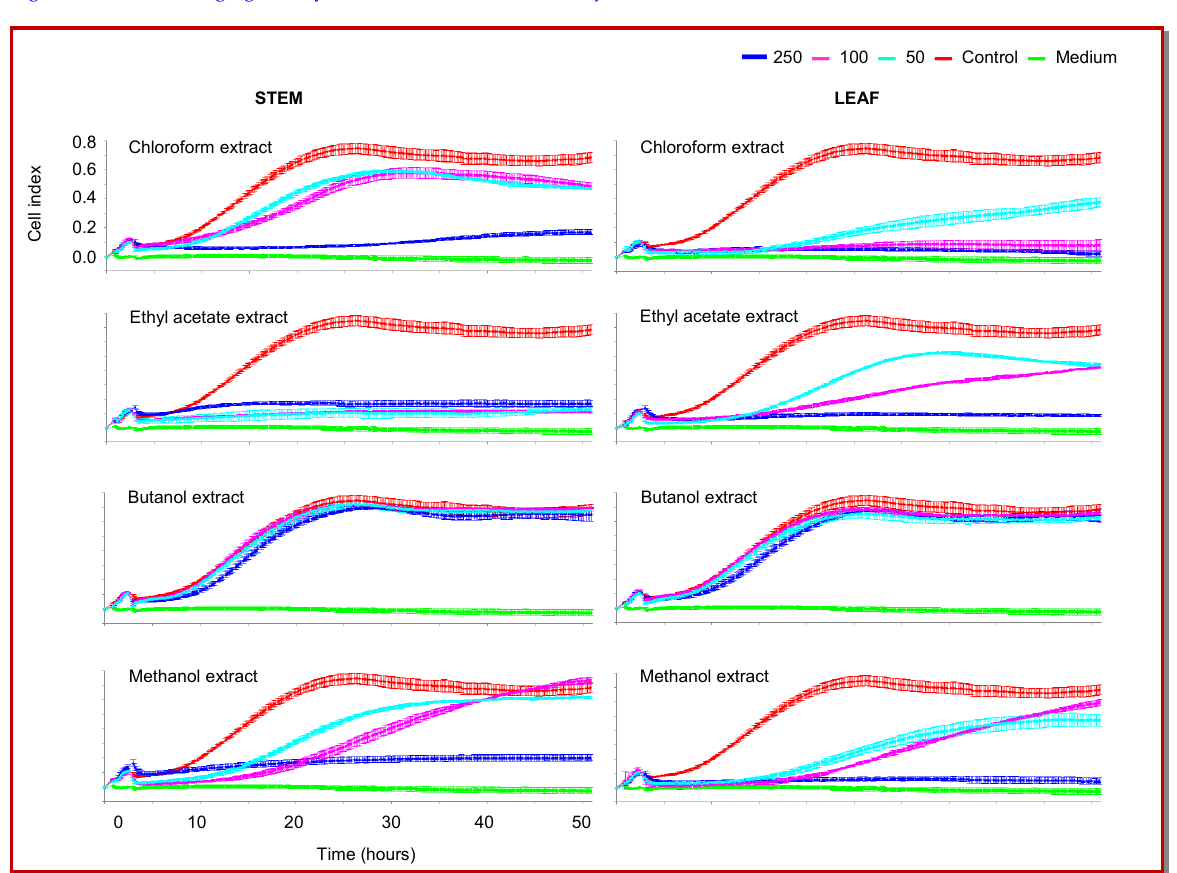
Figure 2 : Proliferation assays of stem (left column) and leaf (right column) extracts at various concentrations (µg/mL)